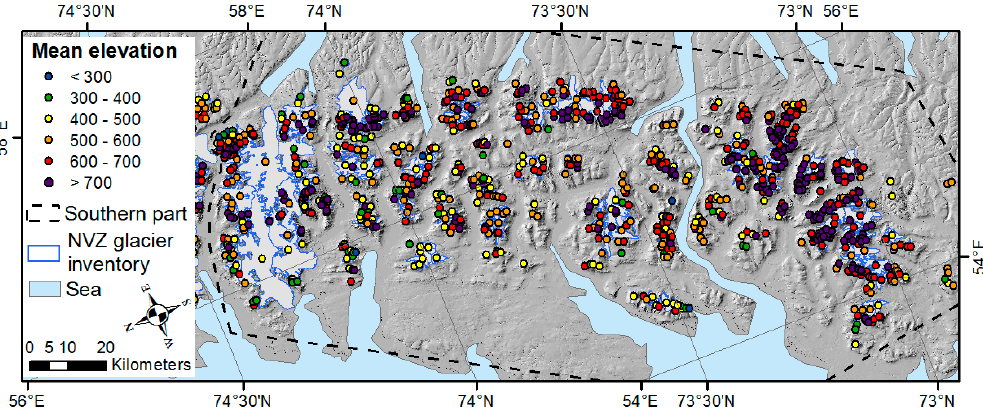
Figure 6. Color-coded visualization of mean elevation for all glaciers in the southern part of NVZ. By area, most of the glaciers are oriented towards the south-east (>35%), north-west (20%) and north (~15%) (Figures 7a and b). Mostly small glaciers are found in the other sectors. When focusing only on the southern part, most of the glacier area and numbers of individual glaciers are exposed to the south-east (>20%), east (>19%) and north-east (~13%).